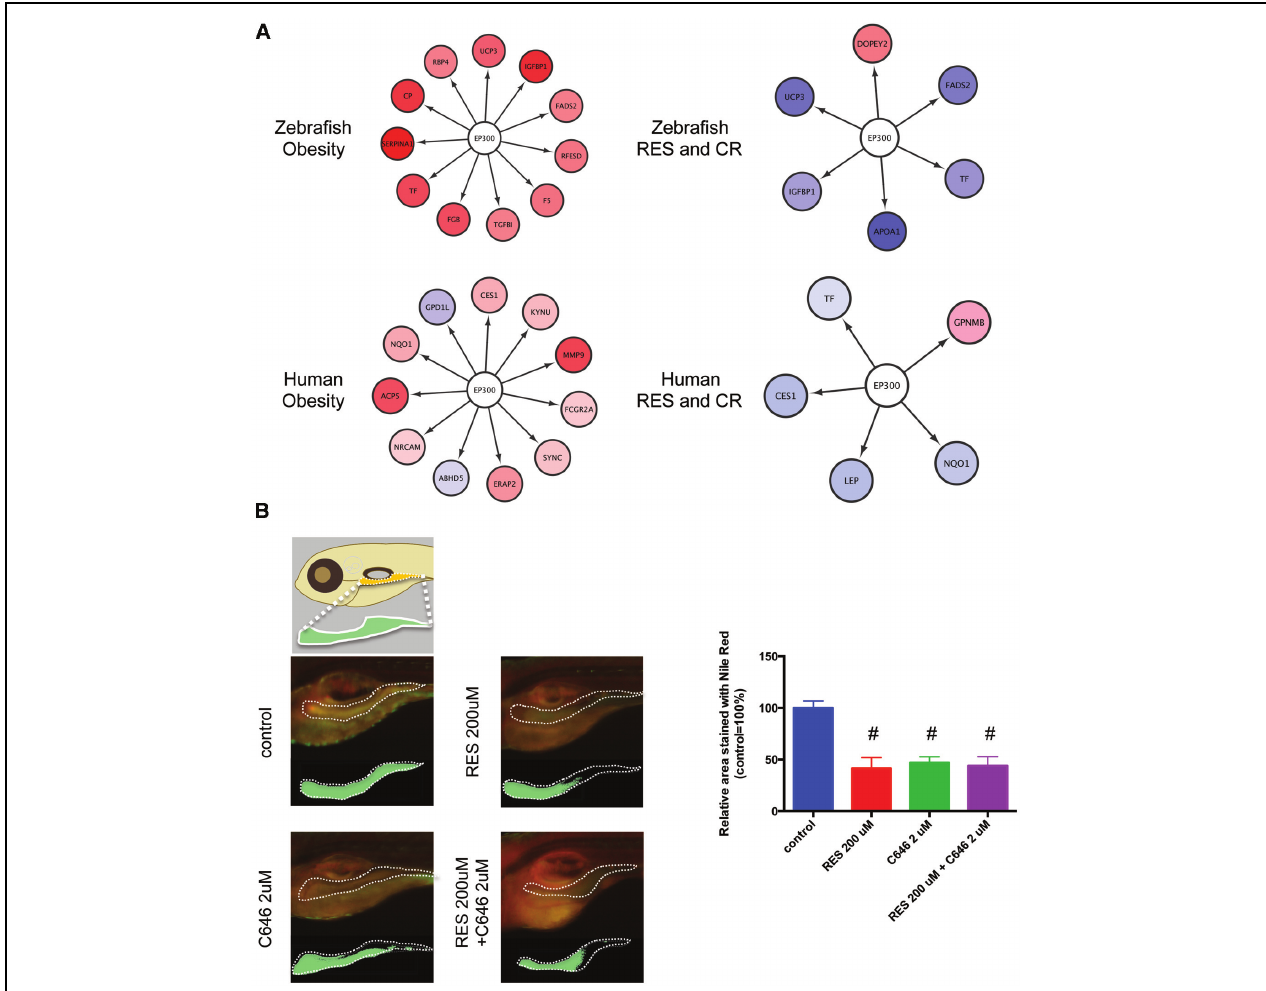
FIGURE 6 | Inhibition of EP300 reduces the adiposity in larval zebrafish. (A) Network between EP300 and the target genes identified iRegulon in adipose tissues of DIO zebrafish and obese humans with and without RES and CR. (B) Changes in the visceral adiposity of zebrafish treated with RES and/or C646. The area stained with Nile Red is shown compared with that of control (arbitrarily defined as 100%). Values are the means ± SEM. N = 10–12/group. # p < 0.05 vs